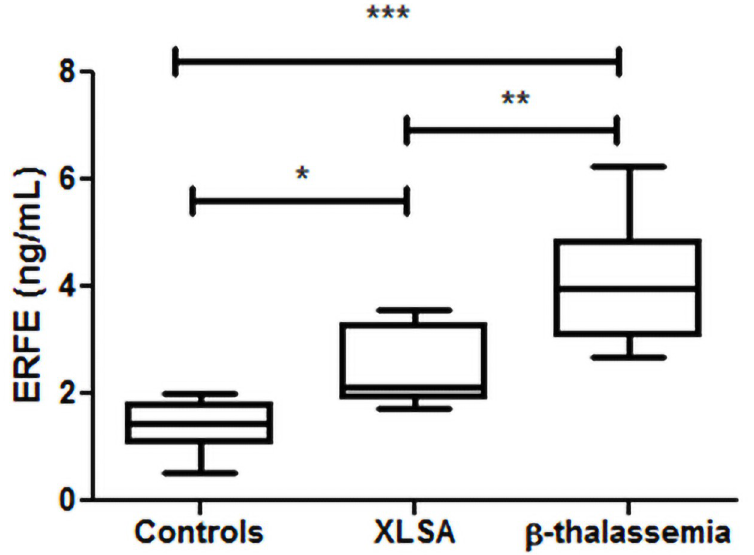
Fig 2. Serum ERFE concentrations in two iron loading anemias. ERFE measurements of healthy controls, X-linked sideroblastic anemia patients and β -thalassemia major patients using the newly developed ERFE assay. Boxes show median and second and third quartiles. Whiskers extend to minimum and maximum values. Statistical analysis was performed using ANOVA with Bonferoni’s post-test. � p < 0.05, �� p < 0.001, ��� p < 0.0001.